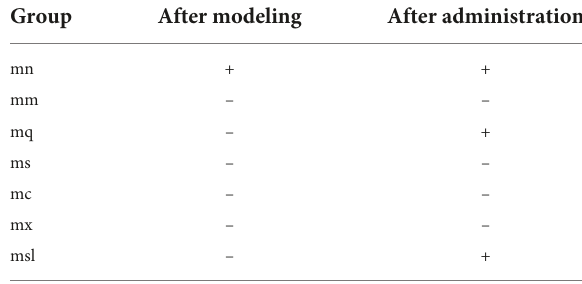
non-parametric Kruskal-Wallis and Wilcoxon rank sum